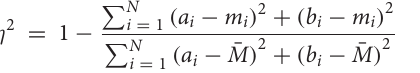
Frontiers in Human Neuroscience |